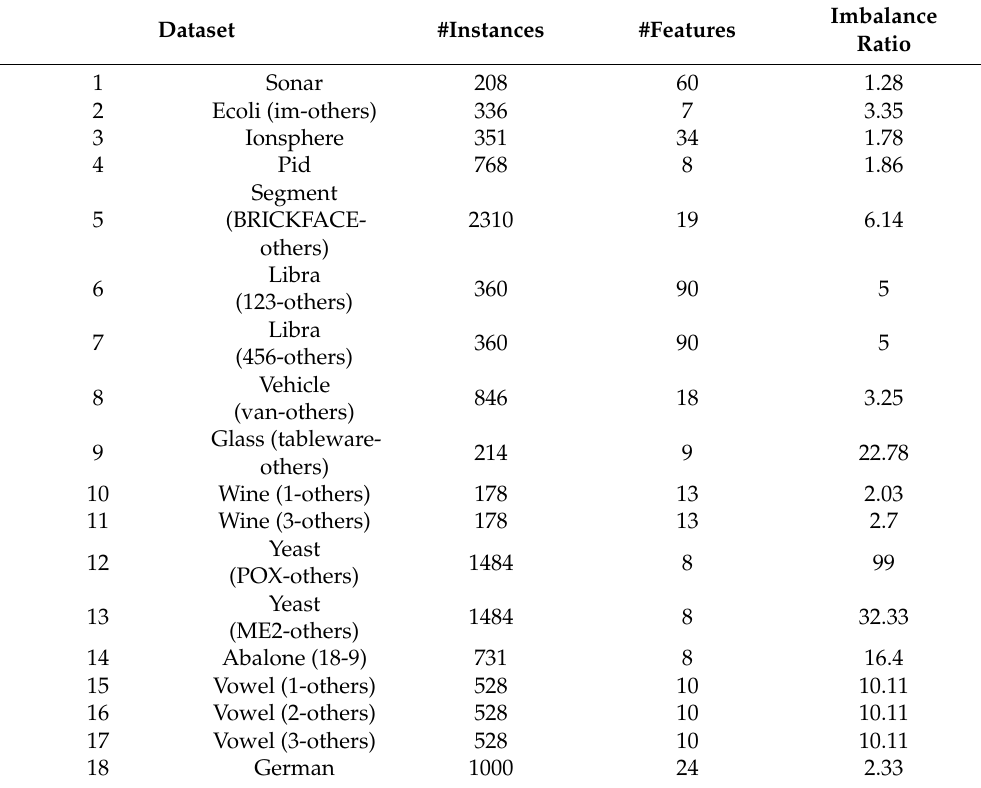
Table 8. Imbalanced datasets